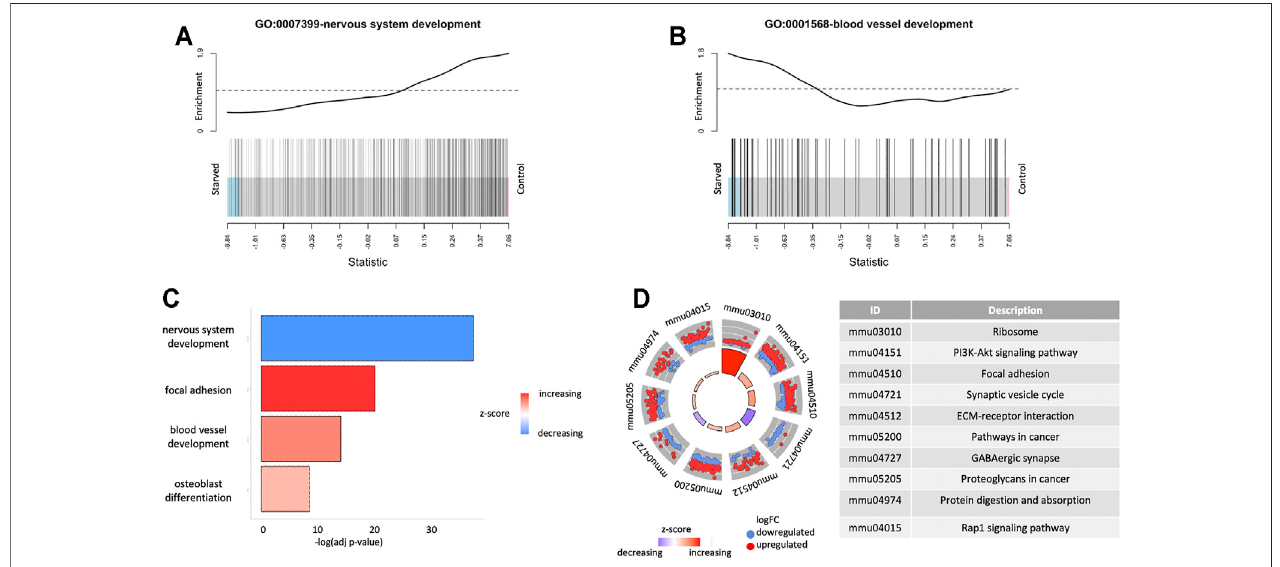
FIGURE 3 | Functional enrichment results for expressed genes. (A) Gene Set Enrichment Analysis (GSEA) for GO terms GO: 0001568-blood vessel development and GO:0007399-nervous system development. (B) Overrepresentation analysis of GO terms for differentially expressed genes. (C) Overrepresentation analysis of KEGG pathways for differentially expressed